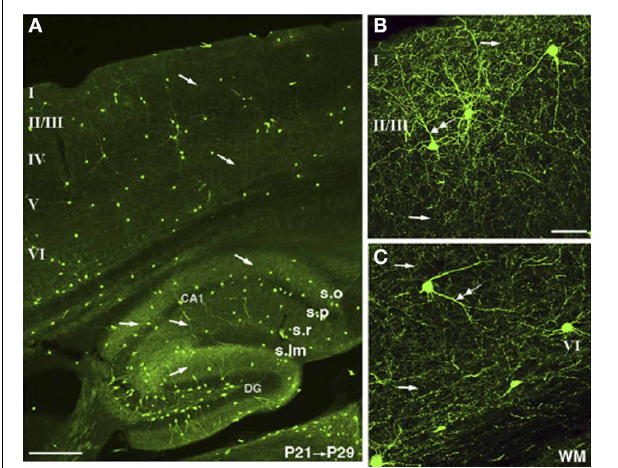
FIGURE 2 | NOS1 positive cells at the LM level in the Cortex and Hippocampus. Cells expressing TdTomato fluoresce in nNOS positive cells in an nNOS-CreER;Ai9 mouse. The TdTomato is rendered green in the images. (A) The nNOS positive cells make up a small population scattered in cortex and hippocampus. (B) A dense and diffuse plexus of neuropil can be seen throughout layer II/III and (C) throughout deeper layers of the cortex. Single arrows indicate axons and double arrows dendrites. Adapted from Taniguchi et al. (2011) with kind permission of the authors and Cell